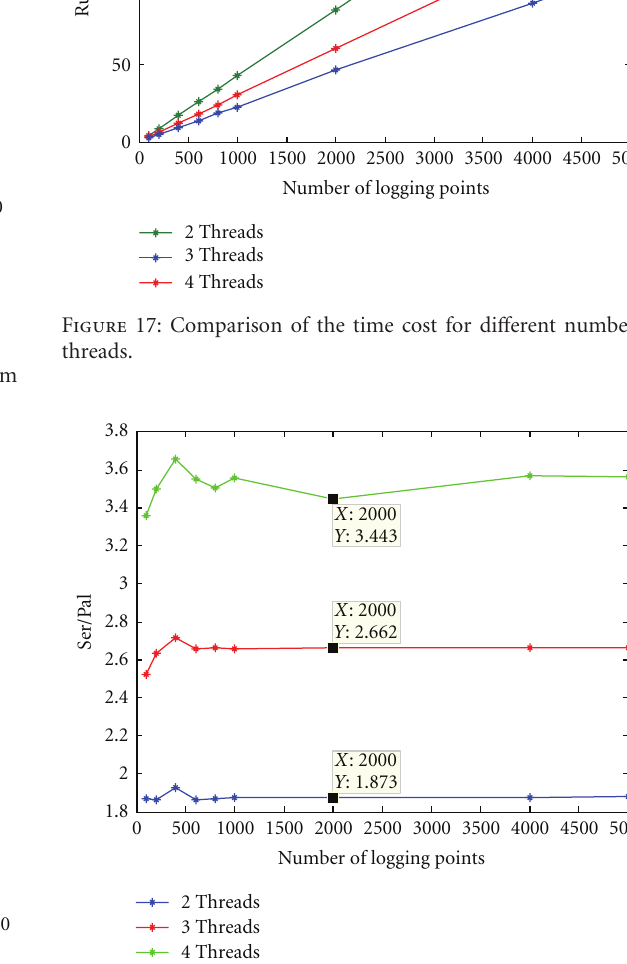
Figure 18: Comparison of the e ffi ciency for di ff erent number of